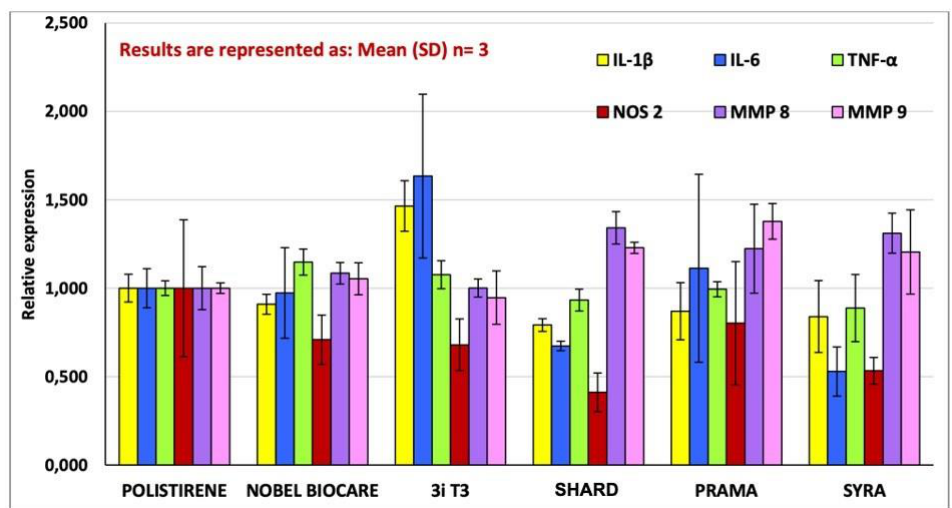
Figure 1. The graph shows the expression of the genes that code for IL-6, TNF- α, NOS 2, MMP -8, and MMP-9 by J774-A1 macrophage cells placed in contact with the implant samples as well as with the negative control (polystyrene for cell cultures) for a duration of 4 h. The data are presented as fold expression of the gene with respect to the control, which is the ratio between gene expression in the sample under examination and gene expression in the control (i.e., if the measured value is 1, it means that the inflammatory cells in contact with the sample under examination express the same quantity of the gene as the inflammatory cells in contact with the negative control; if the value is 2, it means that they express double, and so on). Results are expressed as Mean (SD), n = 3.